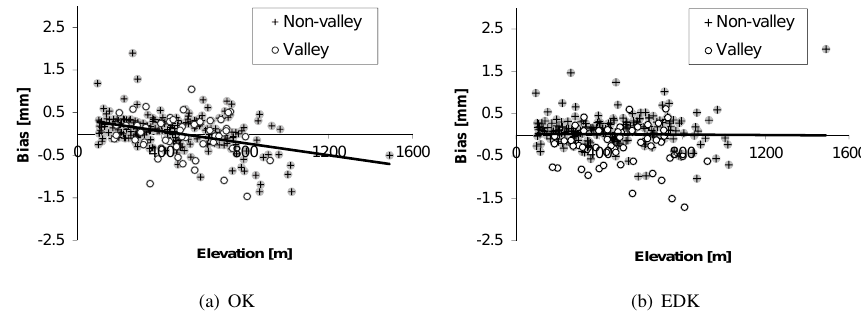
Fig. 15. Bias of valley and non-valley stations for cross-validation of OK and EDK for Baden-Wuerttemberg over 1960 ∼ 2007